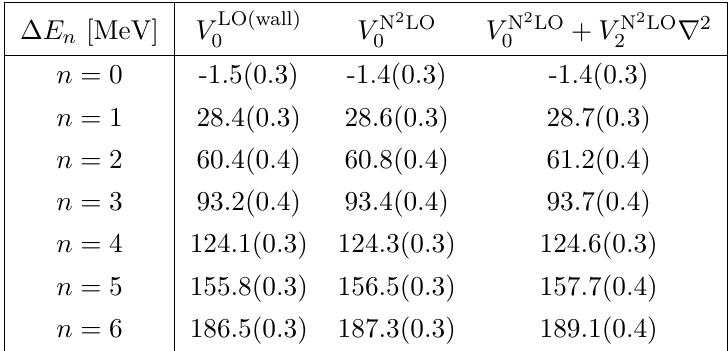
, V N 2 LO , and V N 2 LO + V N 2 LO r 2 at L = 64 0 0 2 0